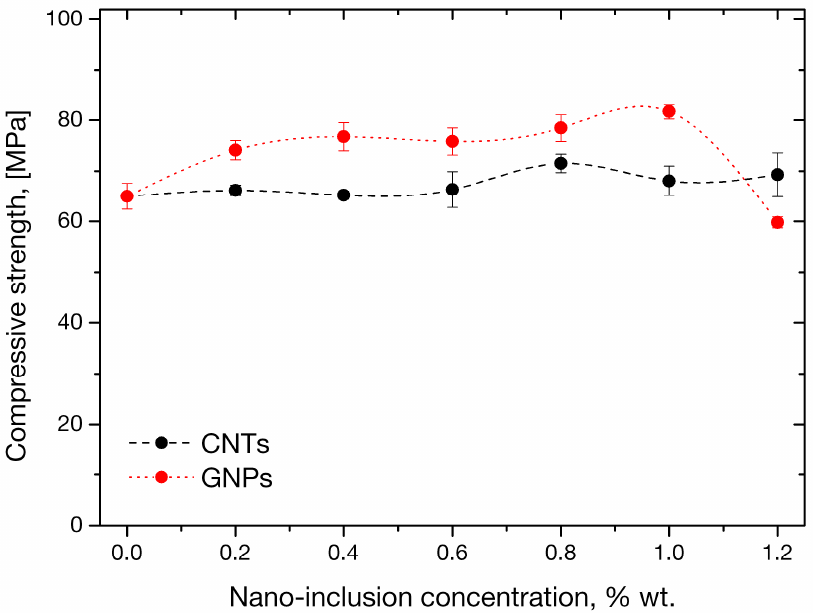
Figure 7. Compressive strength variation in mortars as function of CNT and GNP concentration.